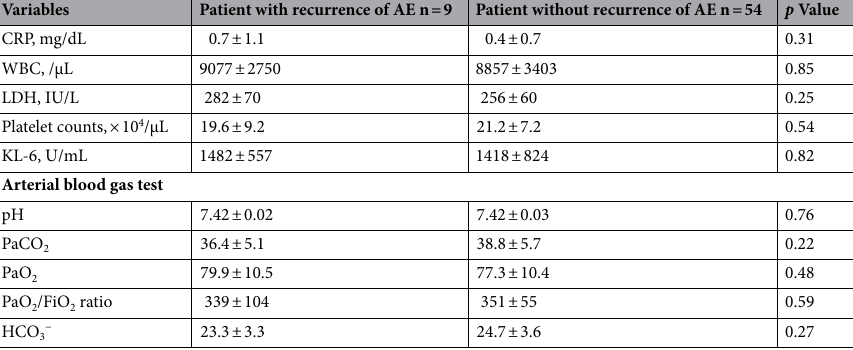
Table 2. Laboratory parameters at discharge for the first acute exacerbation. Values are shown as actual numbers or means ± standard deviation. AE acute exacerbation, CRP c-reactive protein, KL-6 Krebs von der